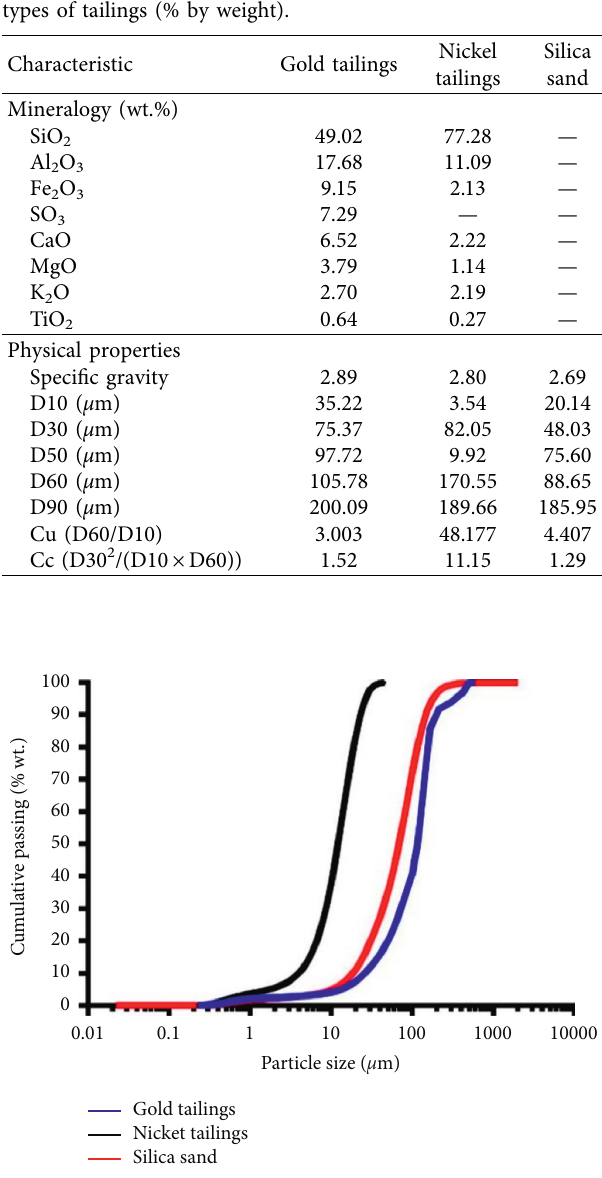
Figure 1: Particle size distribution of gold and nickel tailings and silica